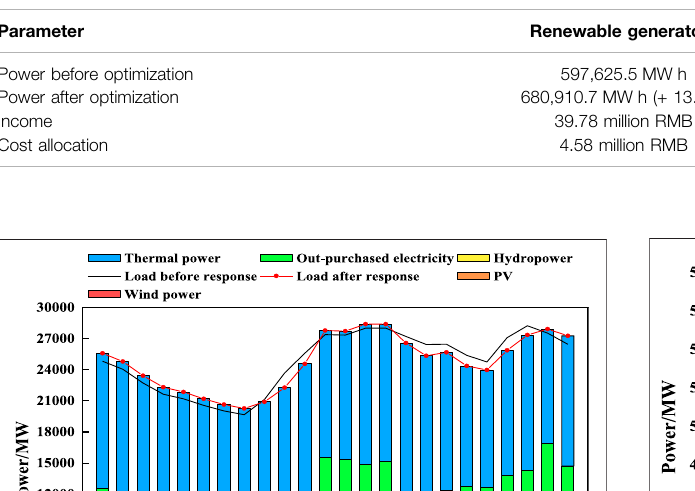
TABLE 2 | Allocation results of user compensation costs for each bene fi ciary body.